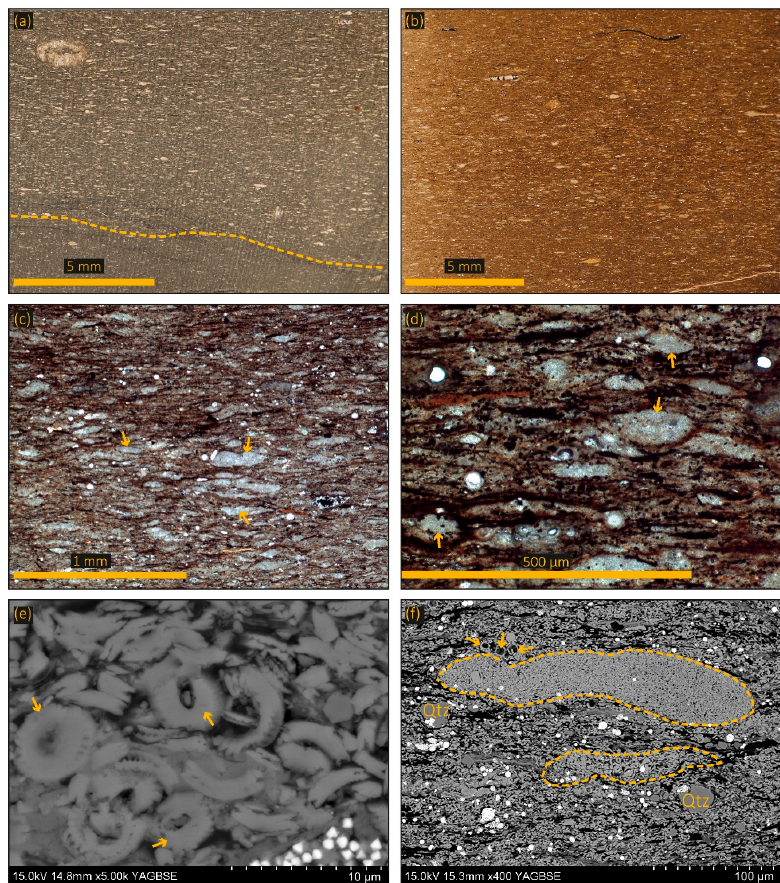
Figure 5. Facies 3: Coccolith-dominated medium mudstone. Sample EB 39.00 m. ( a ) Low power optical micrograph of a slab. Yellow dashed line shows erosional base. ( b ) Low power optical micrograph of a polished thin section. ( c ) Optical micrograph showing the calcareous pellet-rich (yellow arrows) nature of this sample. ( d ) Optical micrograph showing calcareous pellets in an argillaceous and carbonaceous matrix. Note the presence of organic macerals (red horizontal lines) and calcispheres (circled in yellow). ( e ) Backscattered electron photomicrographs showing coccolith plates (yellow arrows). ( f ) Backscattered electron photomicrograph showing the coccolith rich nature of the pellets (dashed yellow lines) and surrounding matrix. Note the presence of quartz grains (Qtz), organic material (OM), and pyrite framboids (py) and the exceptional preservation of coccospheres (yellow arrows in (f)).